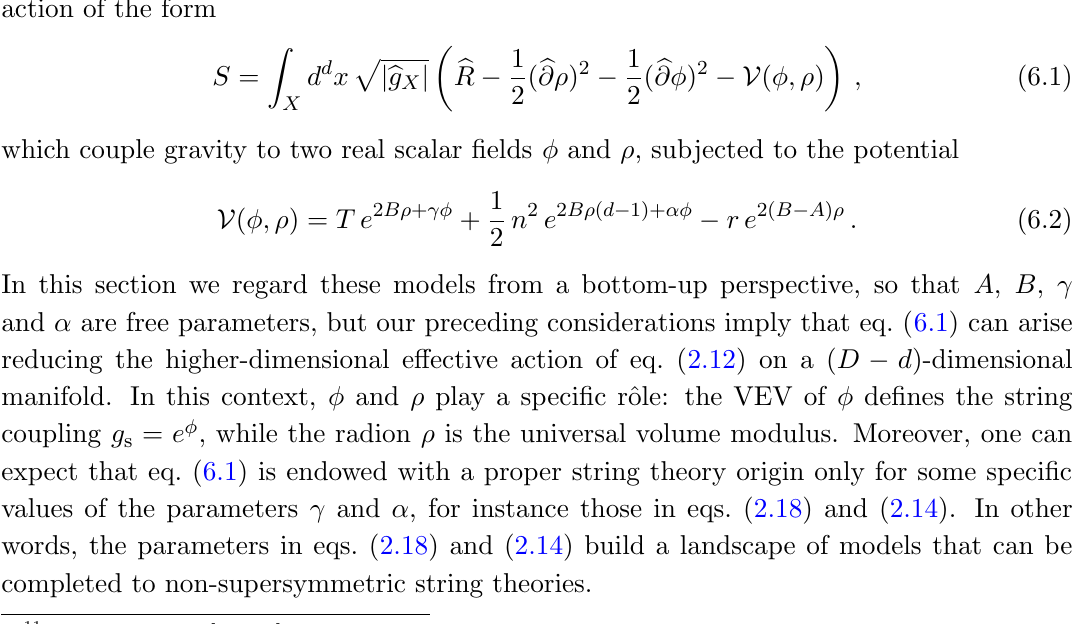
Figure 3 . An example of four-dimensional dS vacuum, where we have highlighted of the sign of the potential and its region of stability. We have chosen (cid:11) = (cid:0) 4 and (cid:13) = 1 (cid:12)elds. Generically, it is expected that only a portion of them constitute the landscape